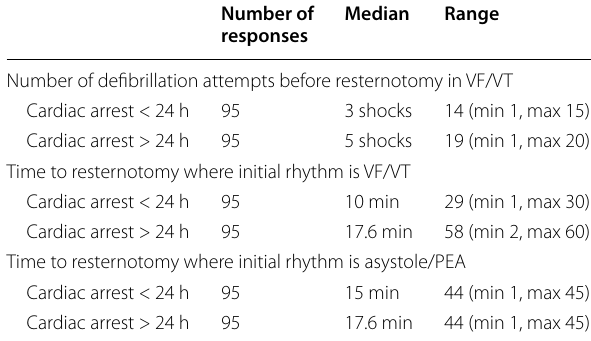
Table 2 Median of defibrillation attempts and time to perform emergency resternotomy Number of Median responses